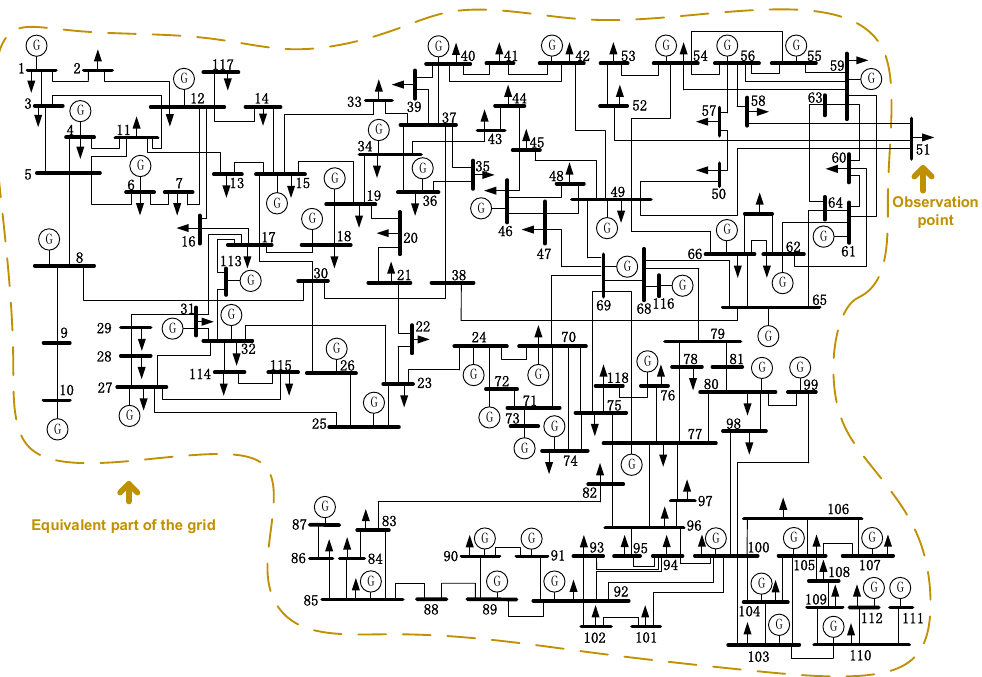
Figure A1. The topology of the IEEE 118-bus system.